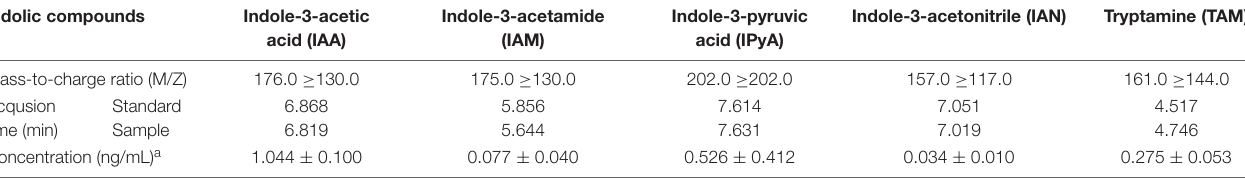
a Values are average ± SD (n = 3).